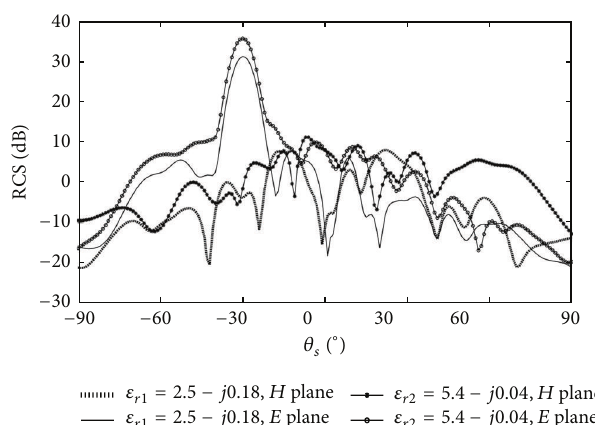
Figure 7: With different relative permittivity of rough surface 𝜀 𝑟2 = = 2.5 − 𝑗0.18 , bistatic RCS from rough surface (30 5.4 − 𝑗0.04, 𝜀 𝑟1 average statistics values).